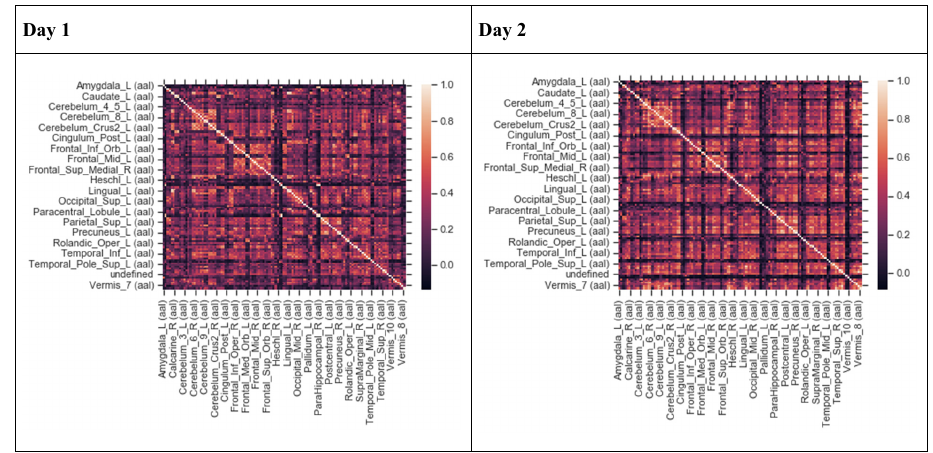
Figure 2. Heat maps depicting Pearson’s correlation coefficients (R) for all Automatic Anatomical Labeling (AAL) regions in Chronic Fatigue Syndrome (CFS) and Gulf War Illness (GWI) datasets for Day 1 and Day 2. The diagonal white line indicates R = 1.